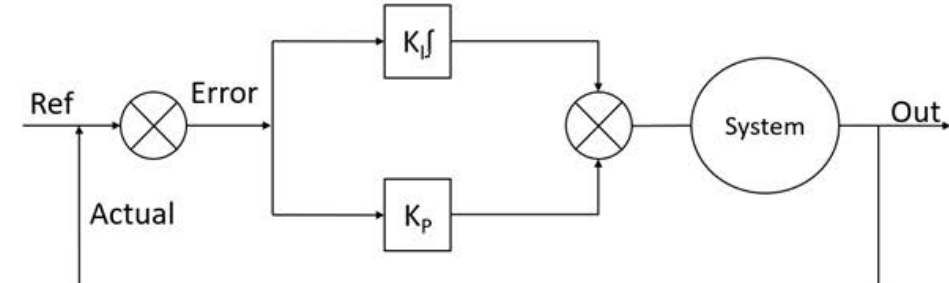
Figure 11. PI Controller.